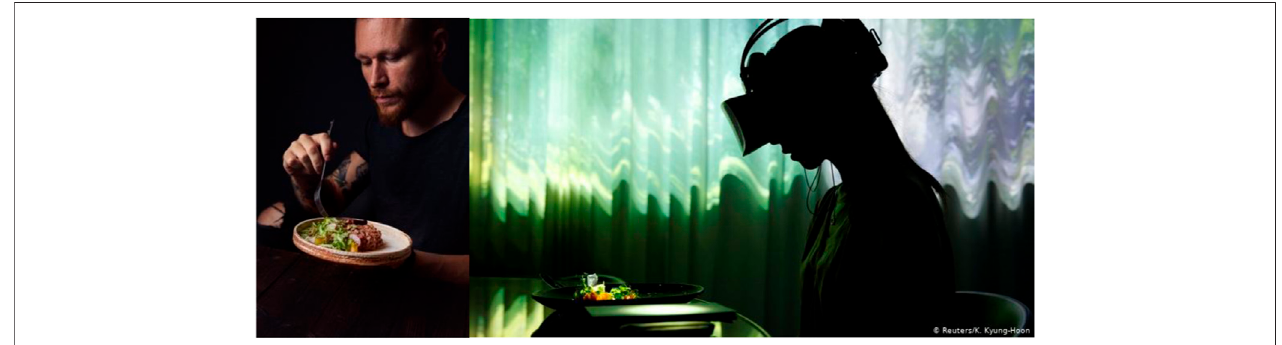
FIGURE2| Lefttraditionaleating,righteatingwithaVRheadset. Left — freestockpicture. Right from “ TreebyNaked ” restaurant ’ .https://www.dw.com/en/tokyo- virtual-reality-restaurant-combines-cusine-with- fi